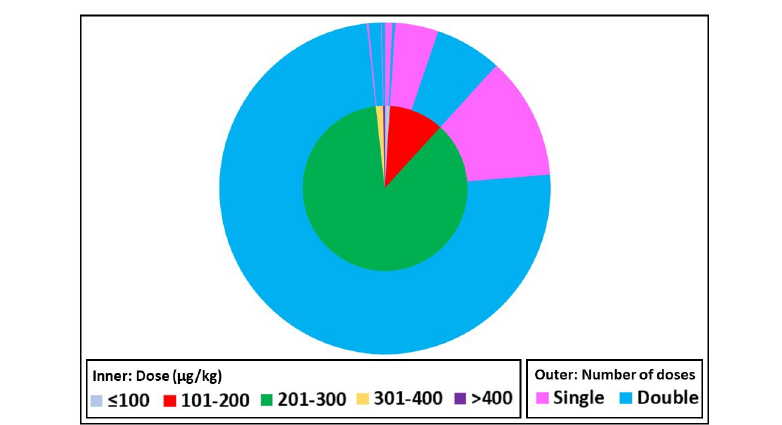
Fig 2. Ivermectin dose and number administered to children weighing less than 15 kg. Fig 2 depicts the ivermectin dose administered in μ g/kg (inner ring) and the number of doses administered (outer ring) that were collected for the IPD database (n = 1,088).